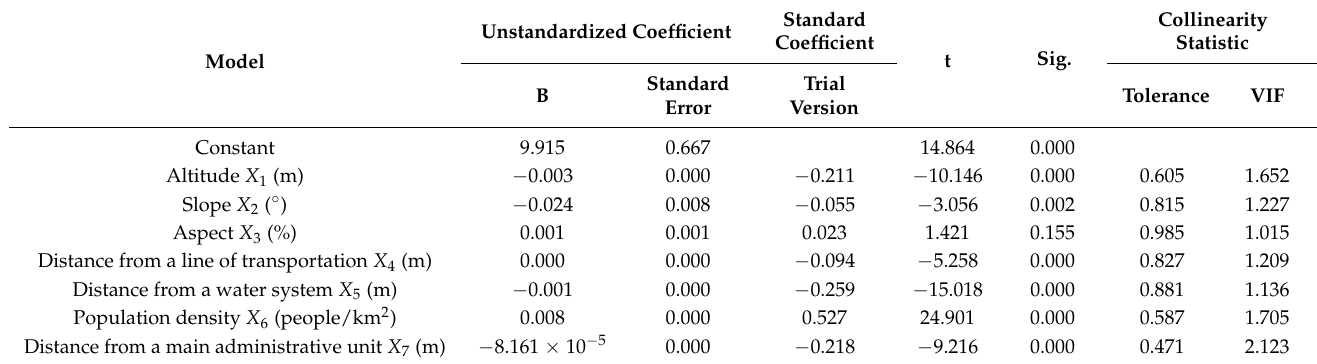
Table 6. Model regression